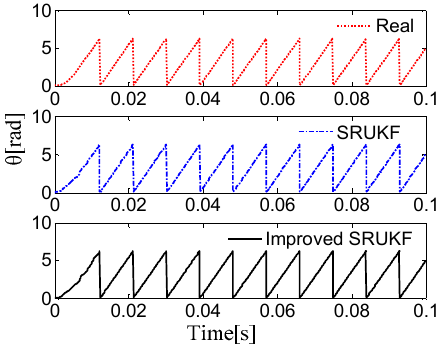
Figure 15. Space position estimation error at parameters disturbance.